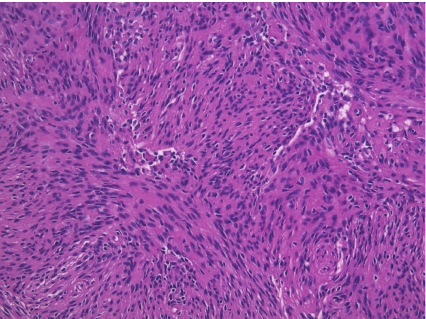
Figure 4: Hematoxylin-Eosin staining. A sample from the first operation is shown. It is possible to appreciate spindle-shaped cells resembling fibroblasts on a matrix abundant in collagen and reticulin. The final diagnosis was WHO Grade I transitional (mixed) meningioma.